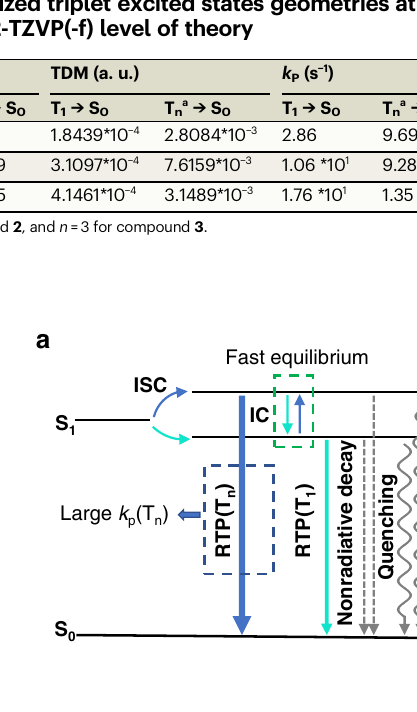
Figure4aillustratesthephotophysicalmechanismofthedualRTP